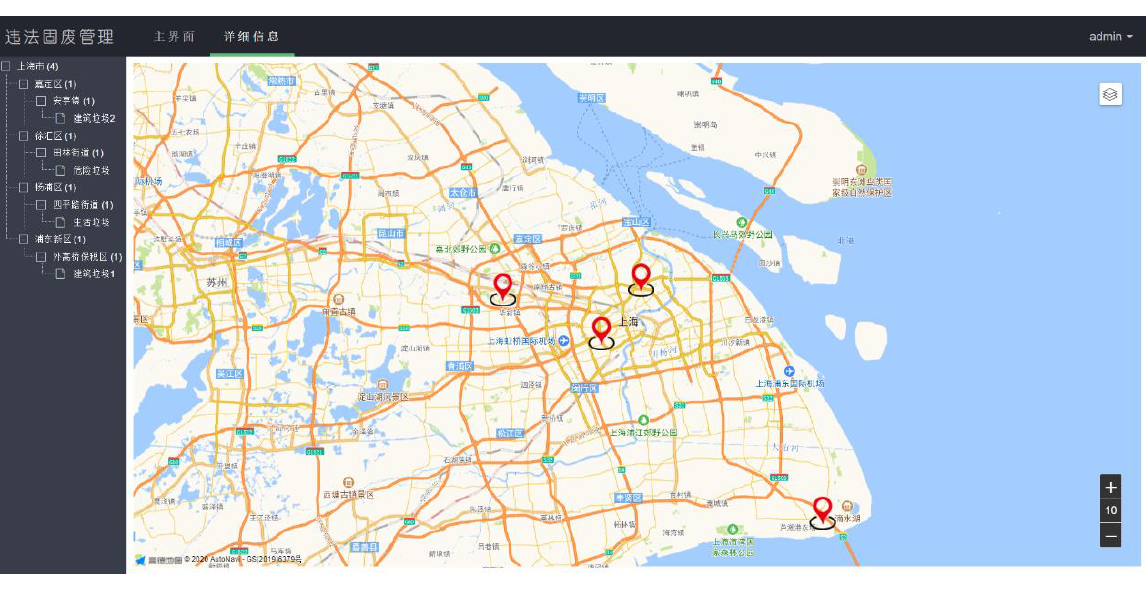
Figure 6. The Gaode map interface on the web-side